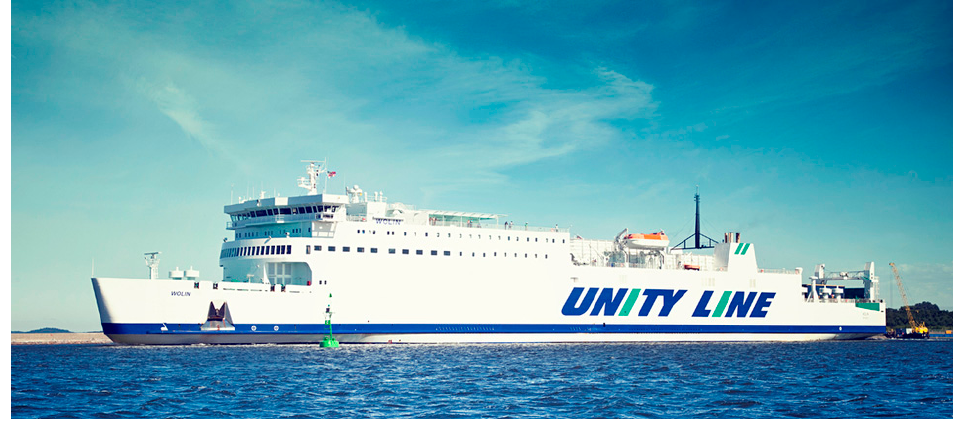
Figure 2. The ferry Wolin—the site of the computing experiments in real conditions [33].